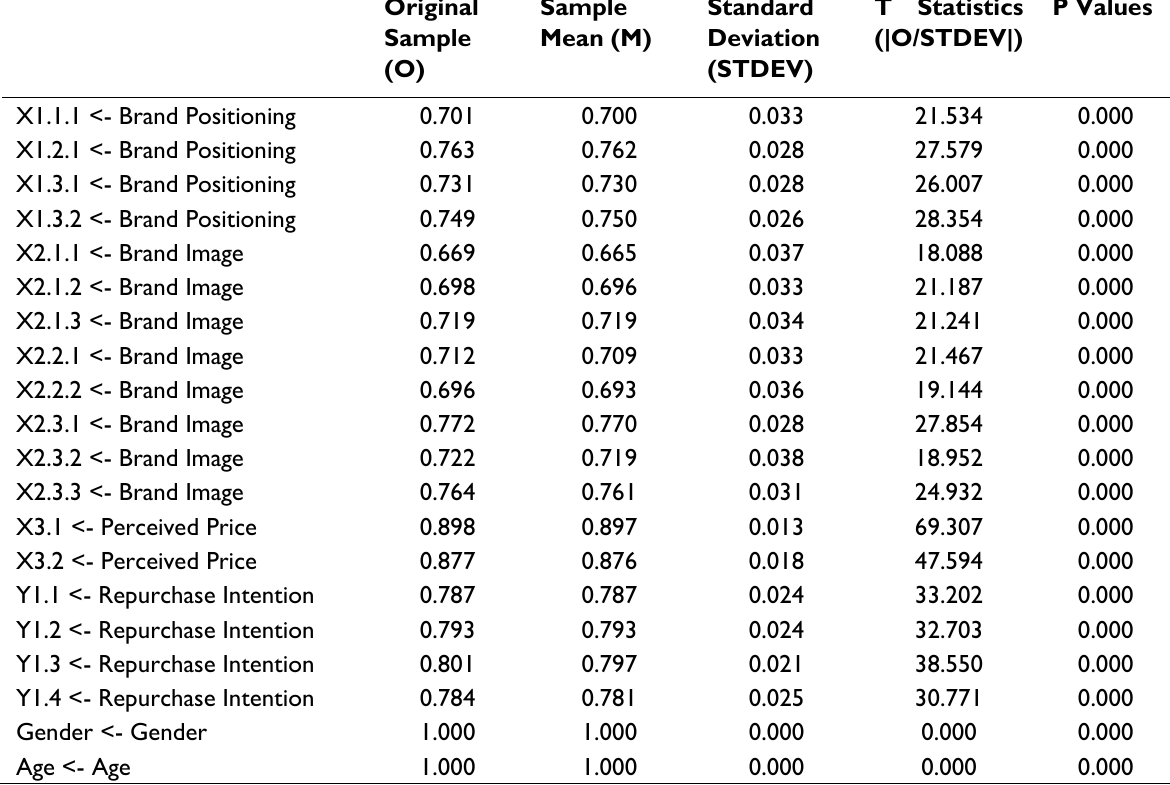
Table 6. Outer Loadings Structural Model (Inner Model Evaluation